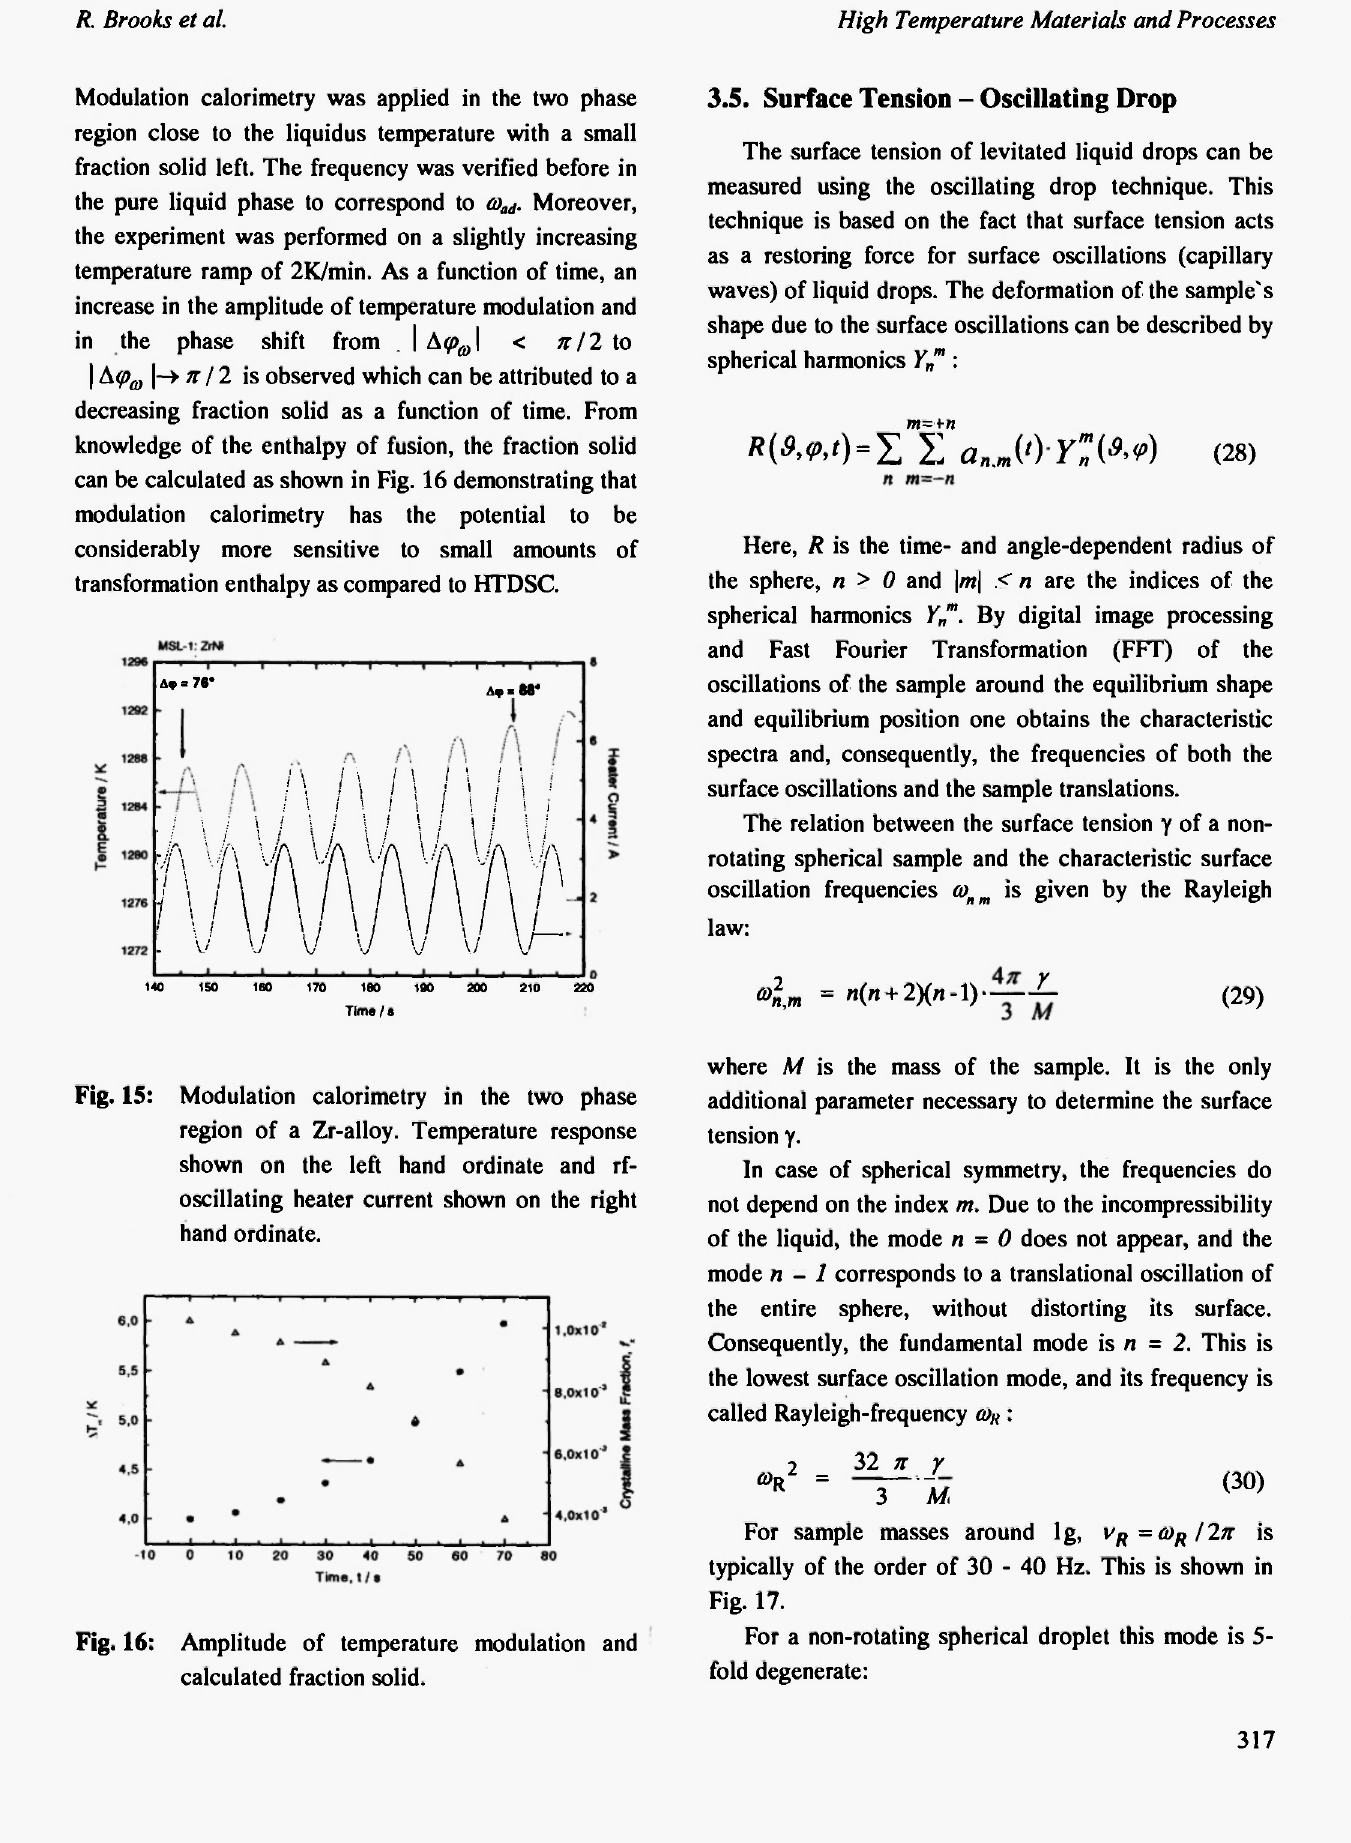
Fig. 16: Amplitude of temperature modulation and calculated fraction solid.